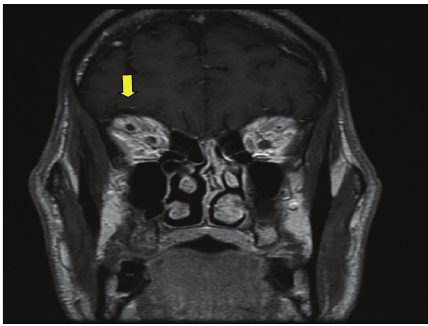
Figure 2: Head MRI with enlarged right superior ophthalmic vein.